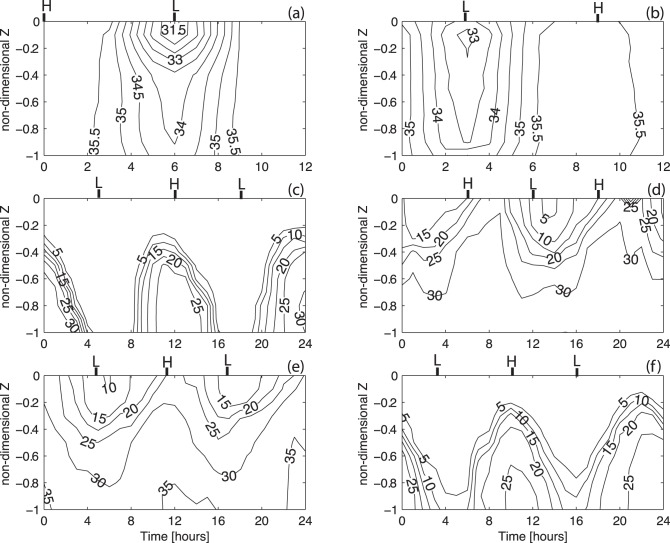
Contour figures of salinity as a function of the non-dimensional depth (Z) and time for all survey periods.
H and L indicate the local high and low-water. (a) 21/02/2002 (station A); (b) 28/02/2002 (station A); (c) 15/01/2004 (station B); (d) 16/06/2004 (station B); (e) 27/08/2004 (station B); (f) 03/12/2004 (station B).